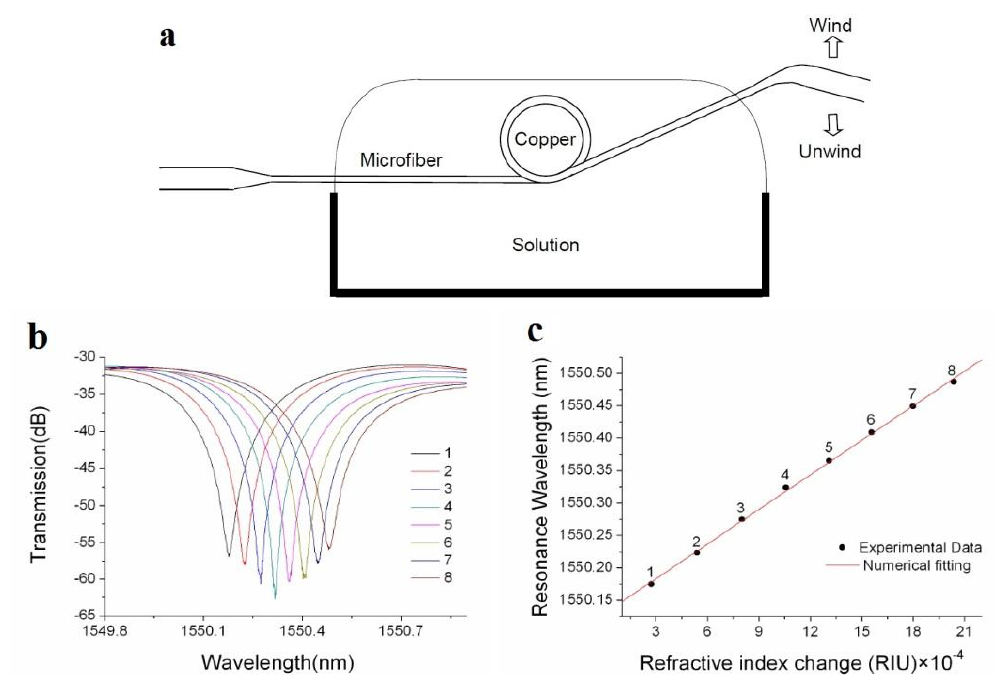
Figure 11. Refractive-index sensor based on copper-rod-supported microfiber loops [51]. ( a ) Schematic side view of a copper-rod-supported microfiber loop; ( b ) Spectral shifts of a resonant peak caused by index change of the solution. The eight peaks are obtained by adding a 5 μL ethanol into a 500 μL water in steps. The loop is about 480 μm in diameter and is assembled with a 2.4 μm diameter microfiber; ( c ) Resonant wavelength as a function of the refractive index change. The black dots are resonant wavelengths extracted from ( b ), and the numerical fitting is obtained with a calculated slope of 17.8